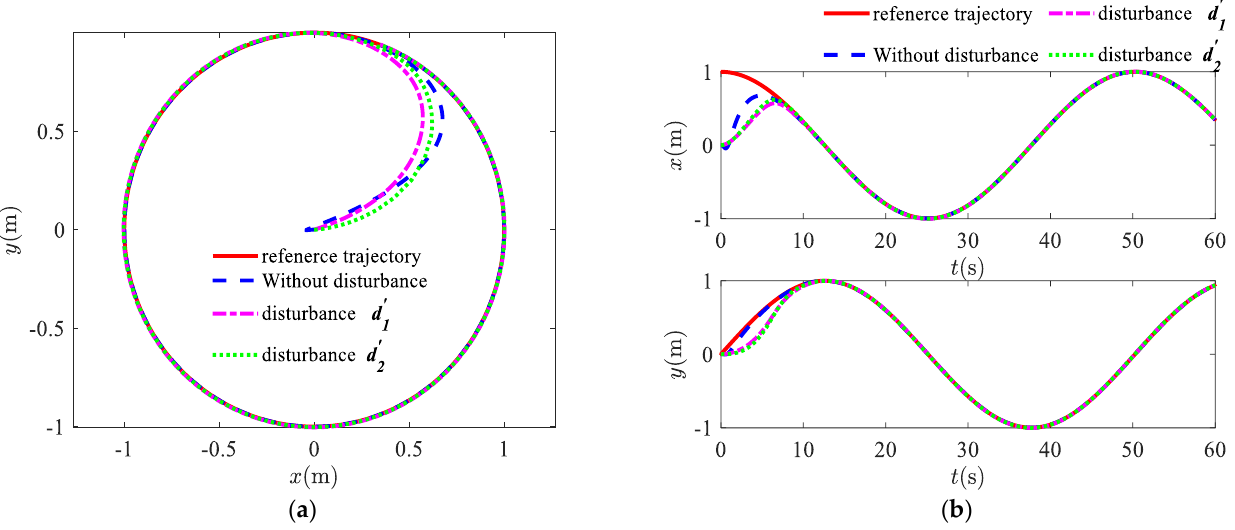
Figure 6. Circular trajectory tracking in three cases: ( a ) trajectory tracking in the x - y plane; ( b ) trajectory tracking in the x -axis and the y -axis directions.